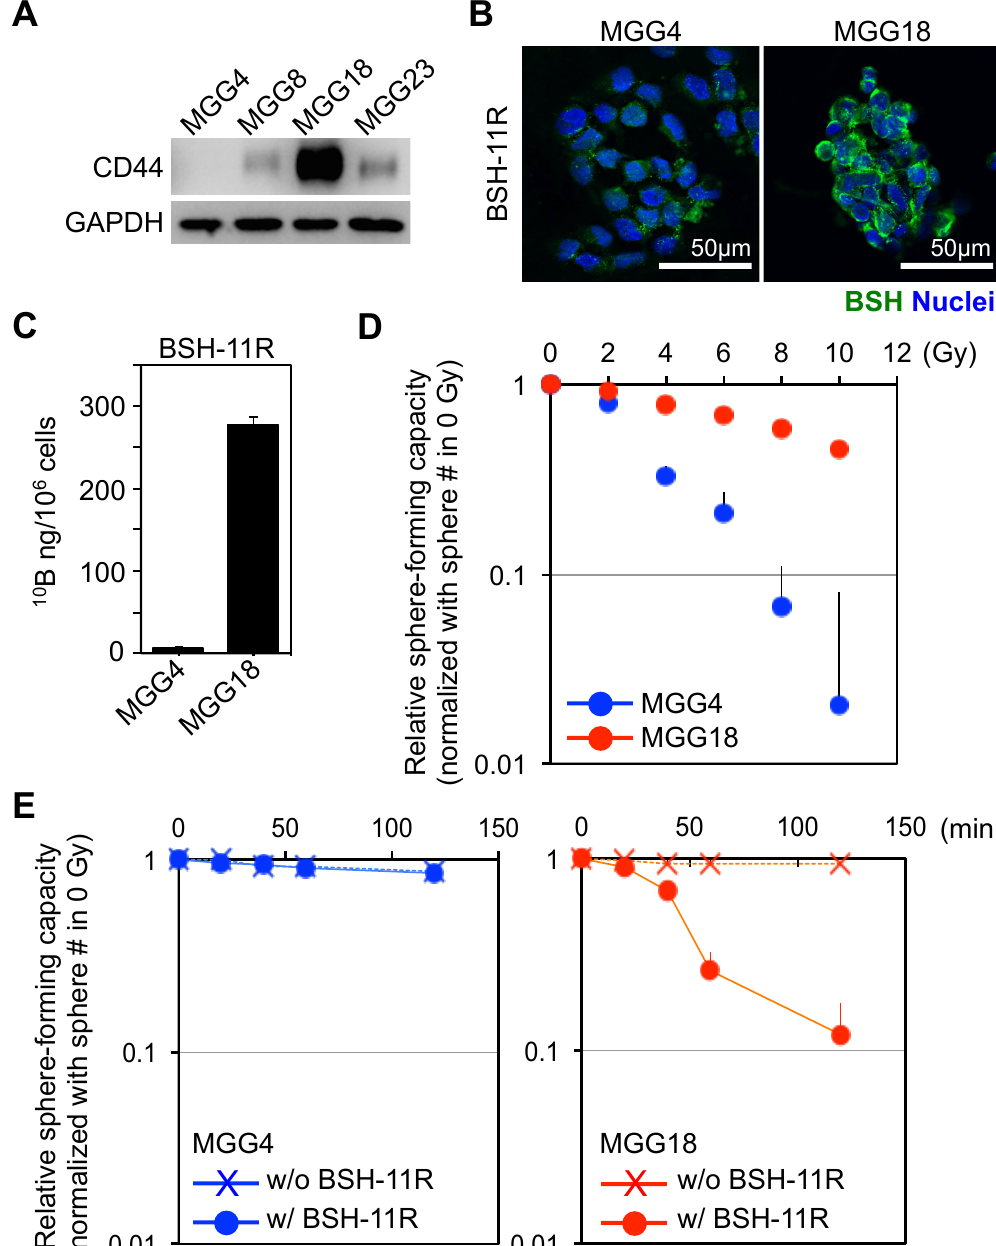
Figure 5. BSH-11R-based boron neutron capture therapy (BNCT) was e ff ective against CD44 High glioma stem-like cells. ( A ) The CD44 profile of glioma stem-like cells. ( B , C ) BSH-11R was e ffi ciently delivered into MGG18 cells. ( D ) The radiosensitivity of MGG4 and MGG18 cells. The MGG18 cells were highly resistant against X-ray irradiation. ( E ) BSH-11R-based BNCT induced remarkable cell death only in MGG18